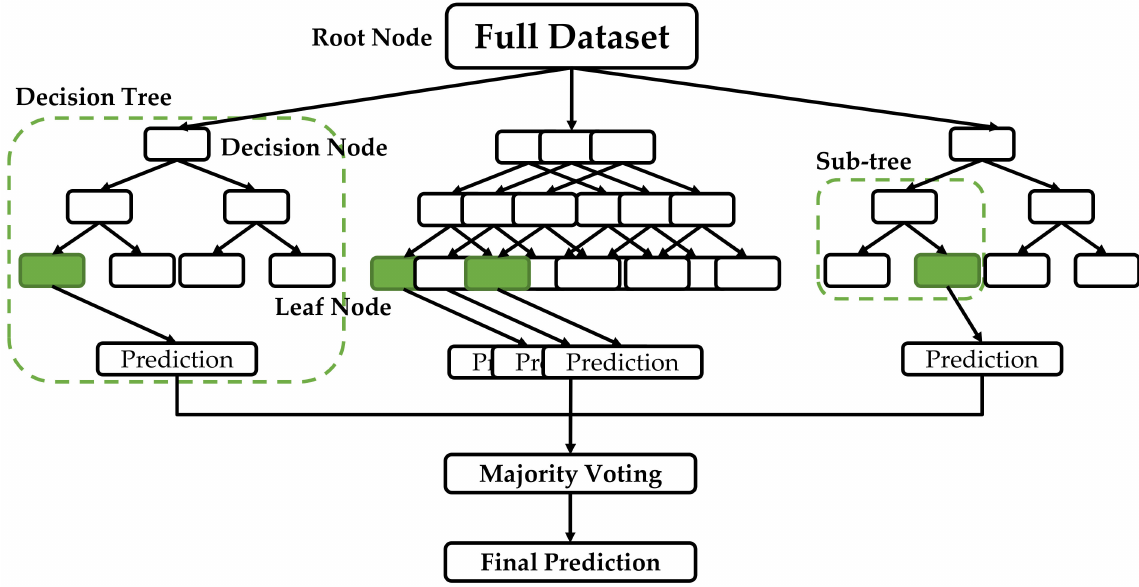
Figure 5. Representation of the random forest classification along with decision